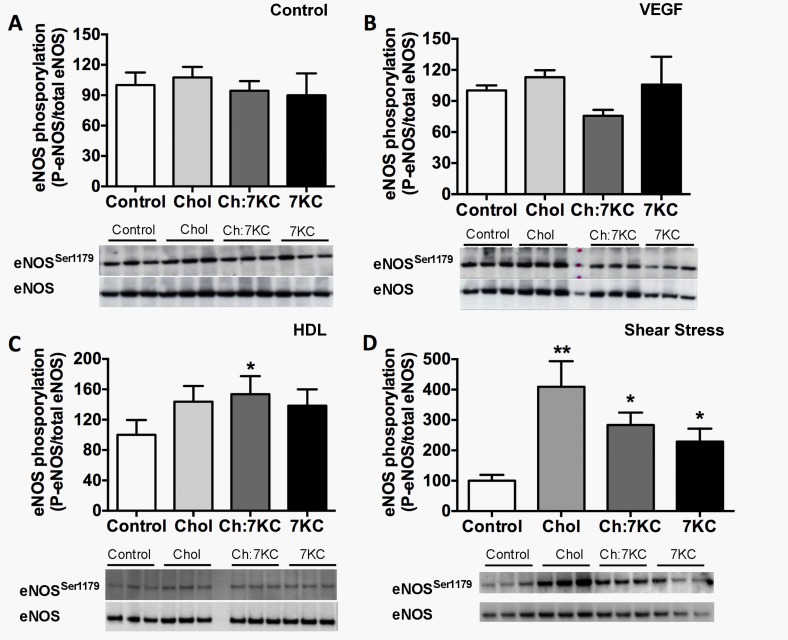
eNOS phosphorylation of sterol-manipulated BAEC in response to various stimuli.BAEC were enriched were treated as above and then either not stimulated (A) or stimulated with VEGF (25 ng/ml) for 5 min (B), 50 μg/ml HDL for 20 min (C) or stimulated with 10 dynes/cm2 shear stress for 5 min (D). Cells were lysed and equal protein amounts analysed by immunoblotting with antibodies against phospho-eNOSSer1179 and total eNOS. Phosphorylation was measured with densitometry of phosphorylated protein divided by the total protein and normalised to control conditions. Data represent means ± SEM from six independent experiments. Significance compared to control was calculated by one-way ANOVA and is indicated by one asterisk reflecting P<0.05 or two asterisks indicating P<0.01.